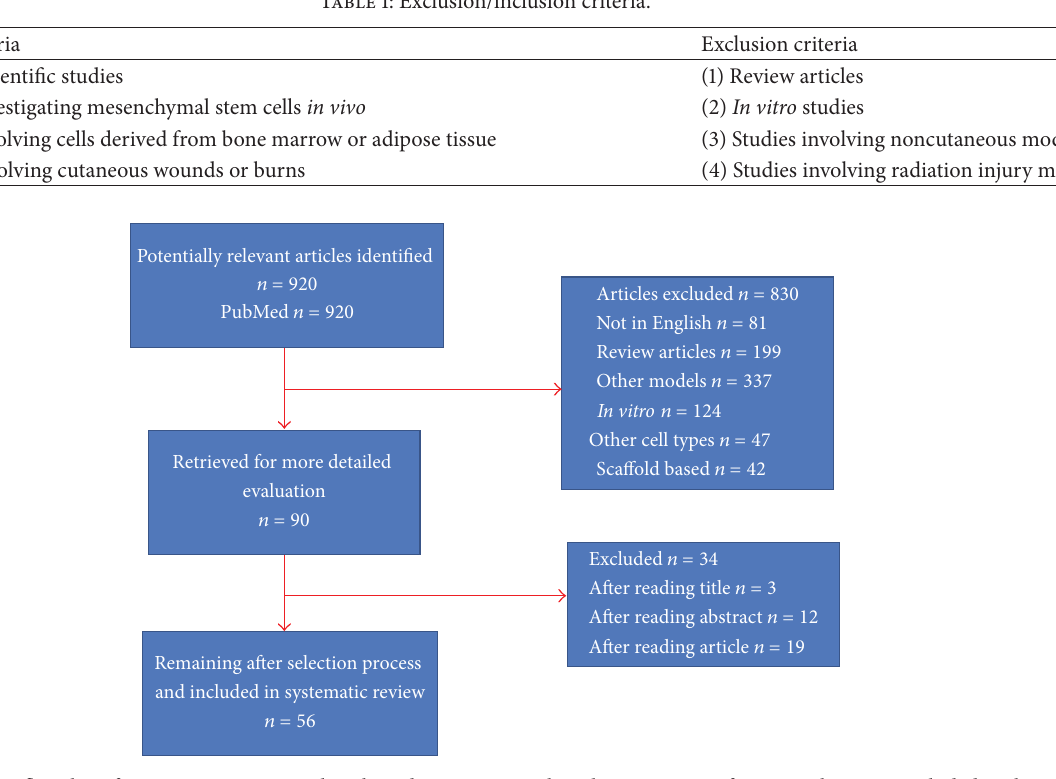
Figure 2: Prisma flowchart for systematic review. Flowchart demonstrating the selection criteria for research papers included in this review. Overall 56 papers were evaluated in this systematic review, including 50 using animal models and 6 using human